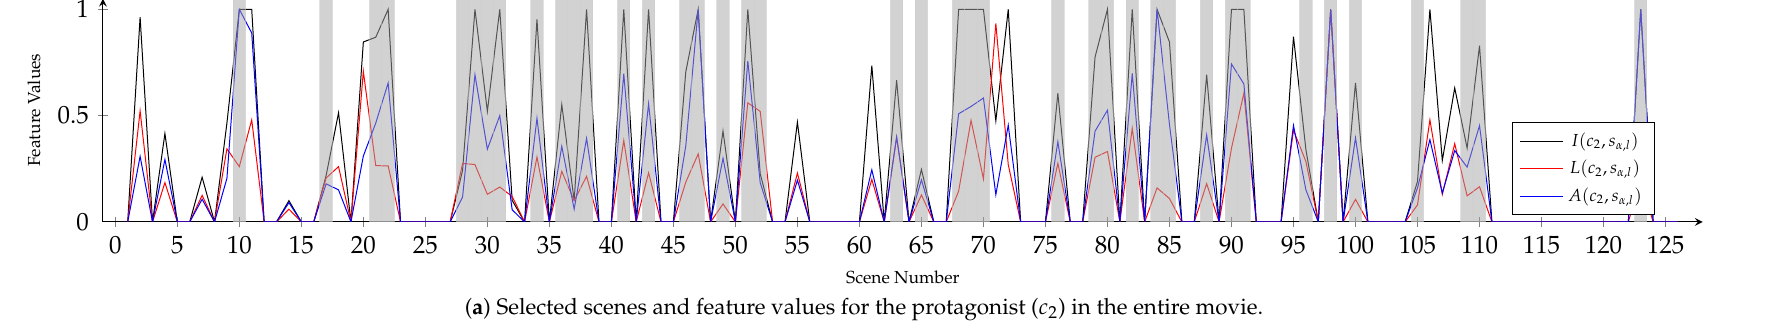
( a ) Selected scenes and feature values for the protagonist ( c 2 ) in the entire movie.